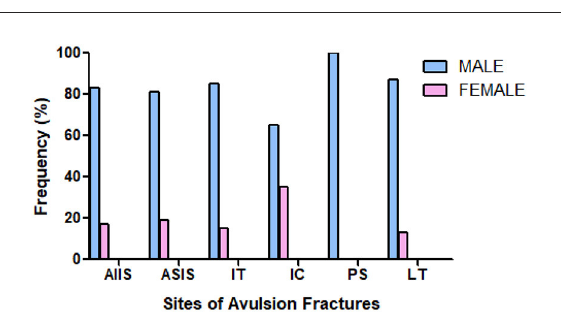
FIGURE2 Histogram of prevalence by gender in site of avulsion fracture.